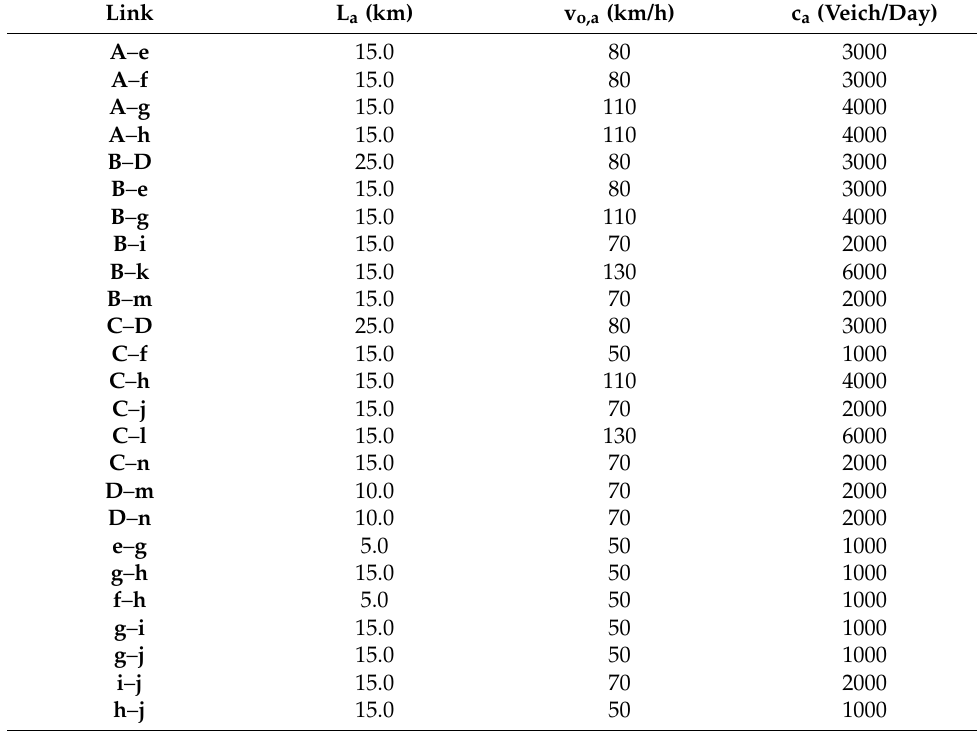
Table 1. Characteristics of the links. The bidirectional links have been identified by the names of the two nodes connected (i.e.: x–y link connecting node x and